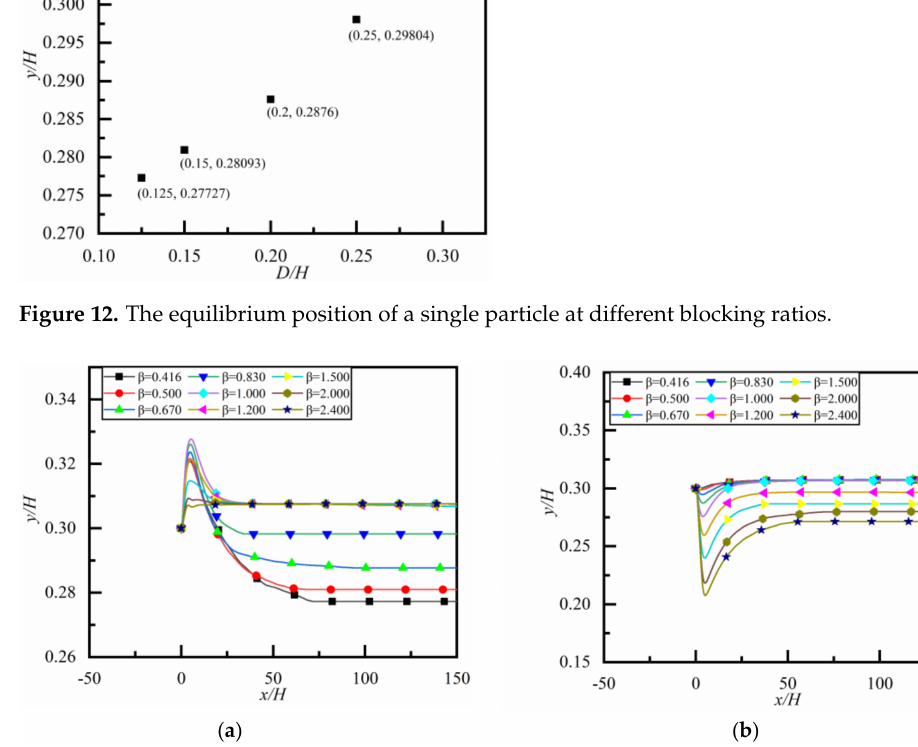
Figure 13. Changes in the equilibrium position of upstream and downstream particles; ( a ) equilibrium position of p1 particles; ( b ) equilibrium position of p2 particles.